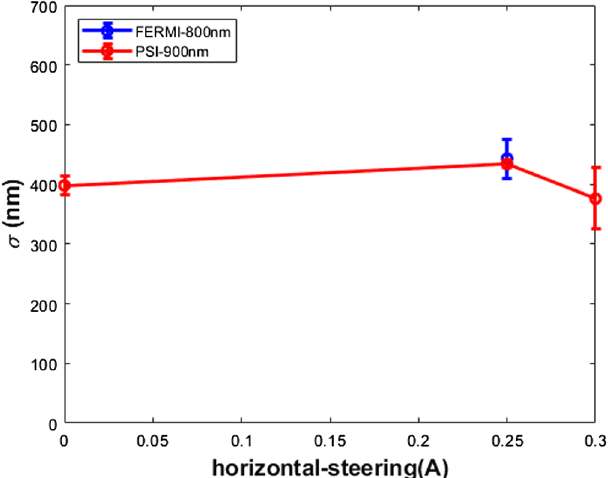
FIG. 7. PSI and FERMI WS measurements of the beam vertical size σ obtained in the machine session of March 31, 2019.